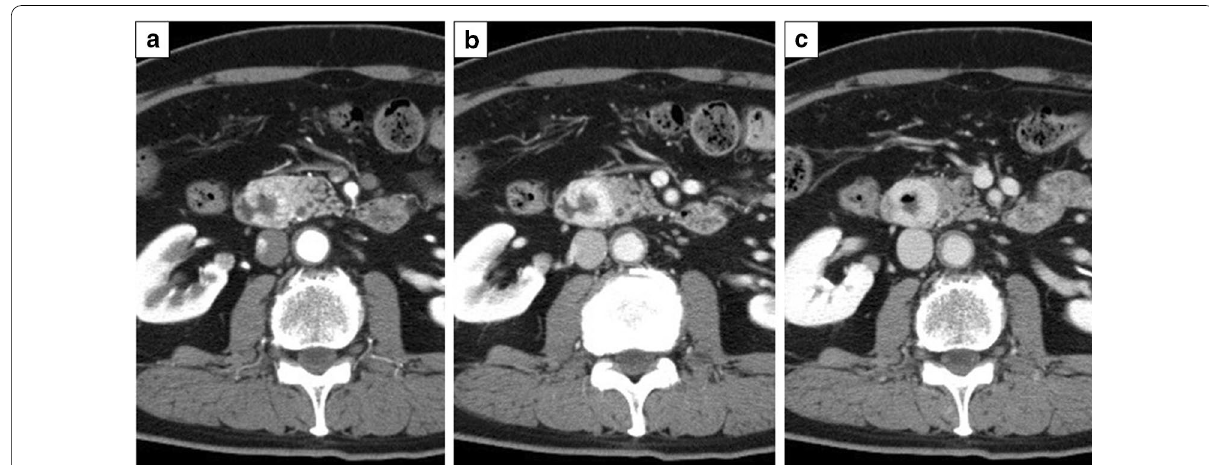
Fig. 1 Dynamic computed tomography (CT) shows a circumscribed tumor measuring 26 mm in diameter with ulceration in the second portion